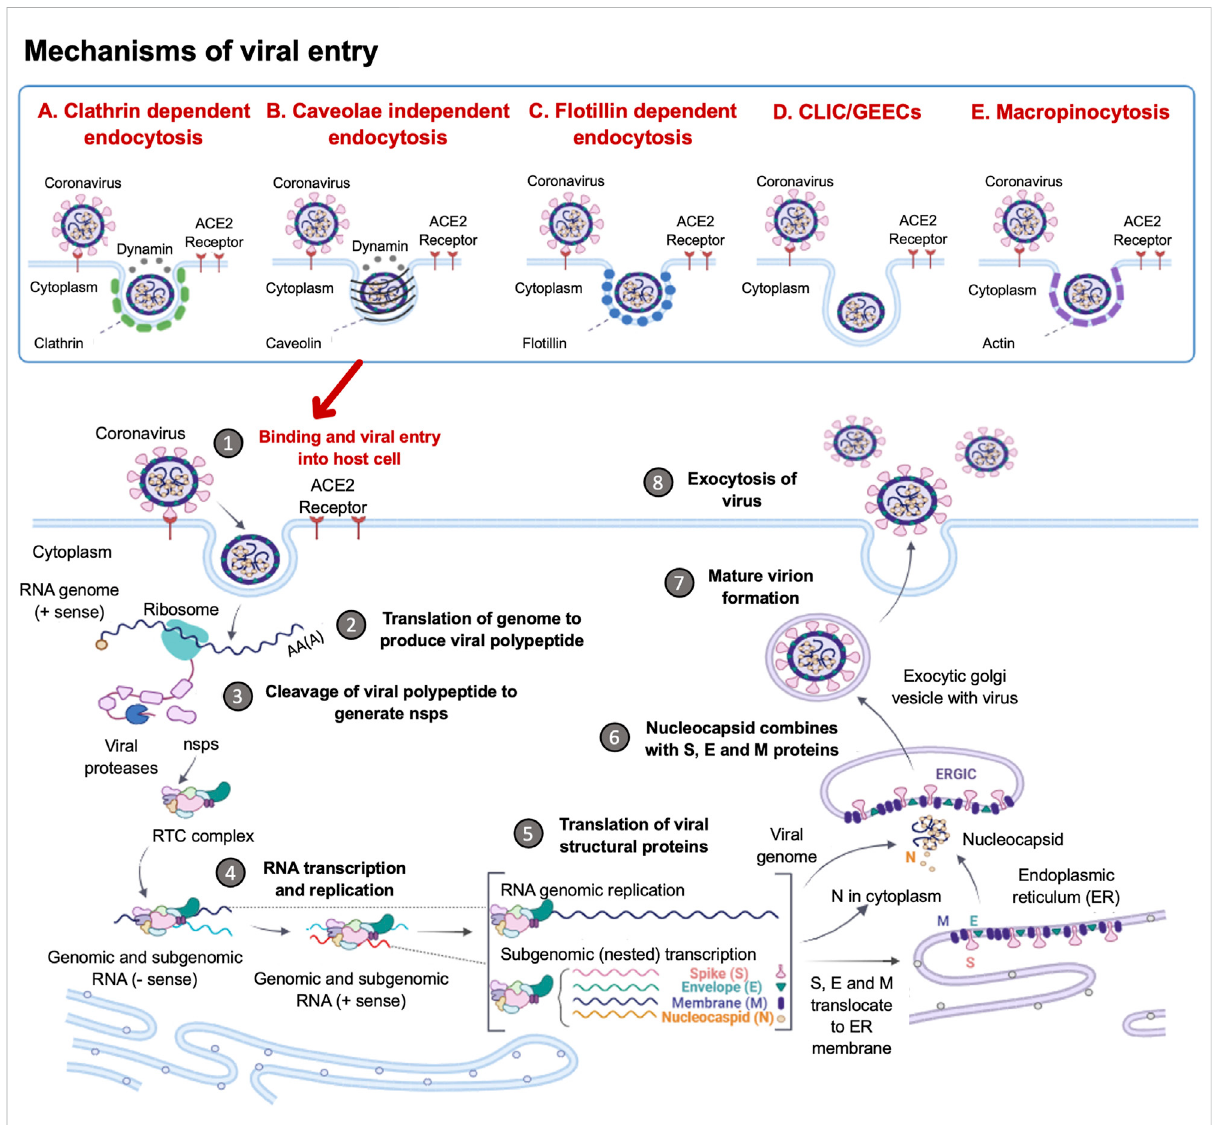
FIGURE 1 Coronavirus Life Cycle in the Host Cell. The potential mechanisms of viral entry into the host cell include canonical Clathrin-dependent endocytosis and non-canonical pathways such as: Caveolae-independent endocytosis, Flotillin-dependent endocytosis, CLIC/GEEC endocytosis andMacropinocytosis.Afterviralentry,thereplication ofthecoronavirusinthetargetcellisinitiated.TheRNAgenomeisuncoated, whichallowsfor the initiation of translation using host ribosomes to produce viral polypeptides. These polyproteins are cleaved by proteases to produce non- structuralproteins(NSPs),whichareresponsiblefortheformationofthereplication-transcriptioncomplex(RTC).TheRTCfacilitatestheproduction of genomic and sub-genomic RNA (-sense and + sense) copies. Following the sub-genomic (nested) transcription, viral structural proteins are produced: spike (S), small envelope (E), membrane (M) and nucleocapsid (N) proteins. The ER facilitates the translation of these viral structural proteins and subsequent embedding on the ER membrane. The nucleocapsids assemble in the cytoplasm and bud off to the Endoplasmic Reticulum-Golgi Intermediate Compartment (ERGIC), where they combine with the structural proteins. The accumulation of viral material causes swelling of the Golgi-apparatus, which results in the formation of smooth structures of virions budding off as enveloped smooth vesicles containing the newly acquired envelopes. These mature virions are released through exocytosis. (Figure created using